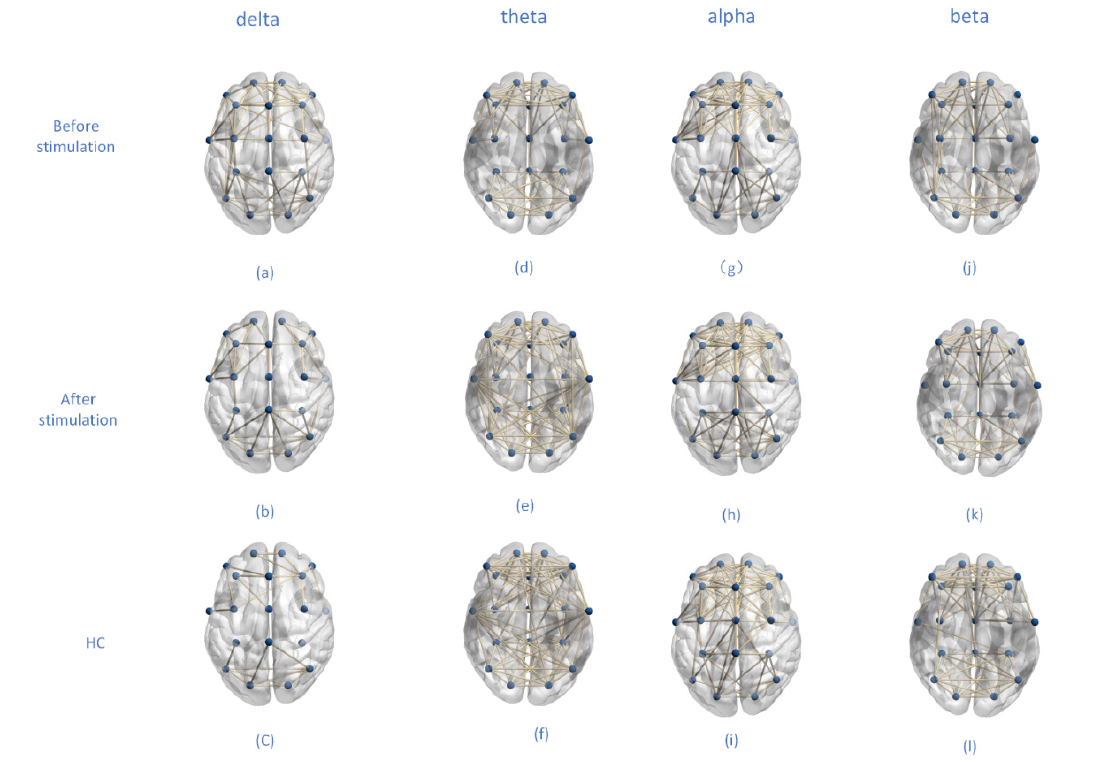
Figure 3. Brain network topology of depressed patients and healthy controls at different frequency bands before and after musical stimulation. Each row shows the state of the subject, and each column shows the frequency band of the signal ( a – l ). The blue dots represent the poles of light, and the yellow lines represent the connections of the channels.